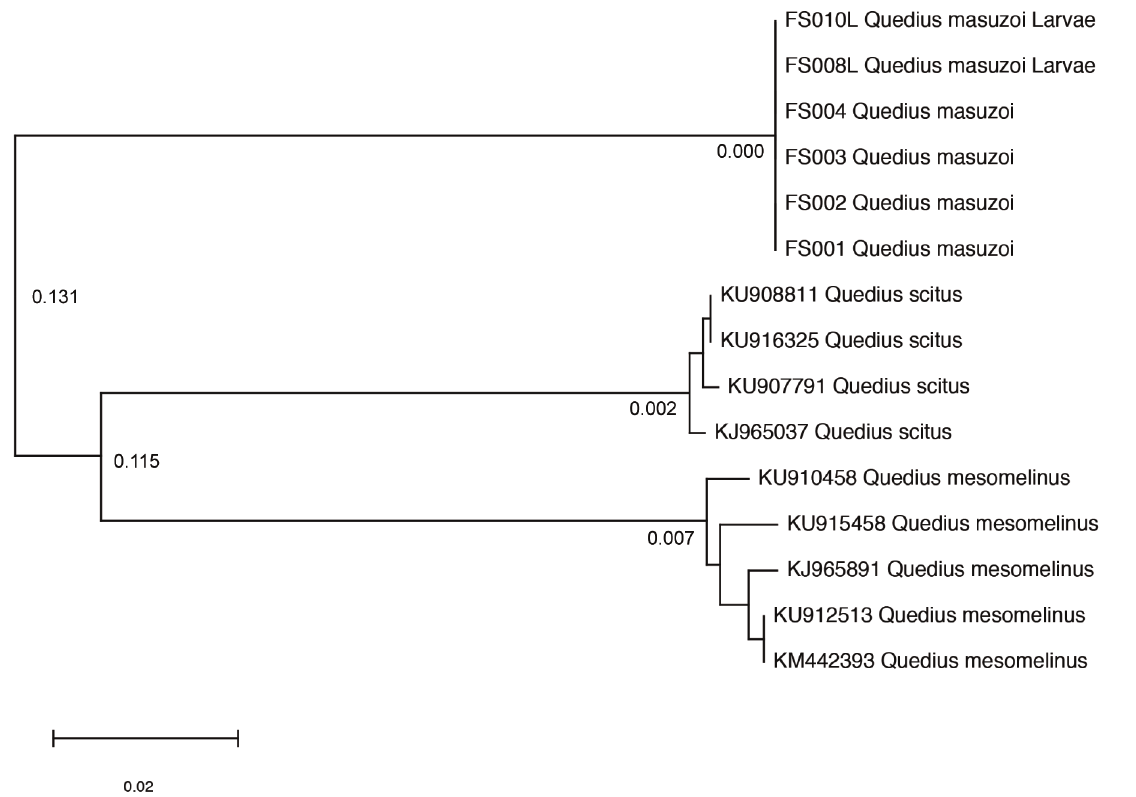
Fig. 10. Maximum likelihood species tree of CO1 barcodes. The sequences of Quedius masuzoi Watanabe, 1989 were produced in this study. Sequences of Quedius scitus (Gravenhorst, 1806) and Quedius mesomelinus (Marsham, 1802) are from GenBank. Numbers represent within (on branch) and between (at node) species dissimilarity of CO1